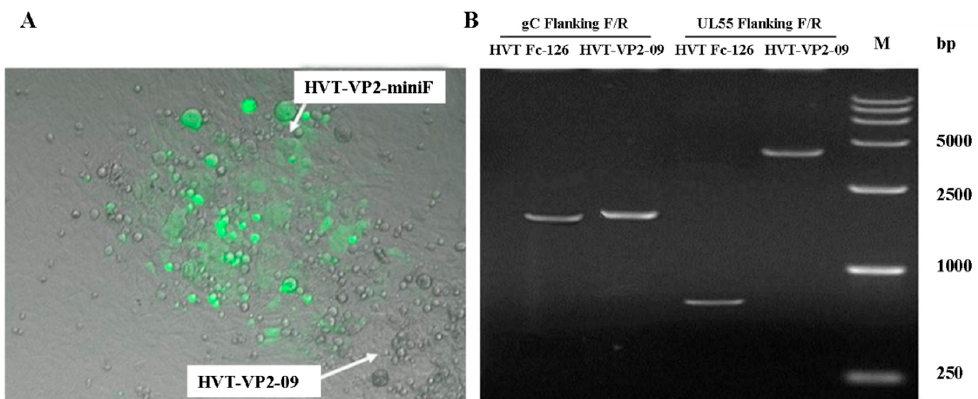
Figure 4. Rescue of the recombinant HVT BAC containing the VP2 expression cassette: ( A ): Rescue plaques were observed under UV light (488 nm). Fluorescent plaques were infected with recombi- nant HVT-VP2-09-miniF, and nonfluorescent plaques were infected with recombinant HVT-VP2-09 that recovered the gC gene. ( B ): DNA of a PCR fragment amplified with DNA of HVT Fc-126 or HVT-VP2-09 as a template and gC FlankingF/R or UL55 FlankingF/R as primers (Table 1).